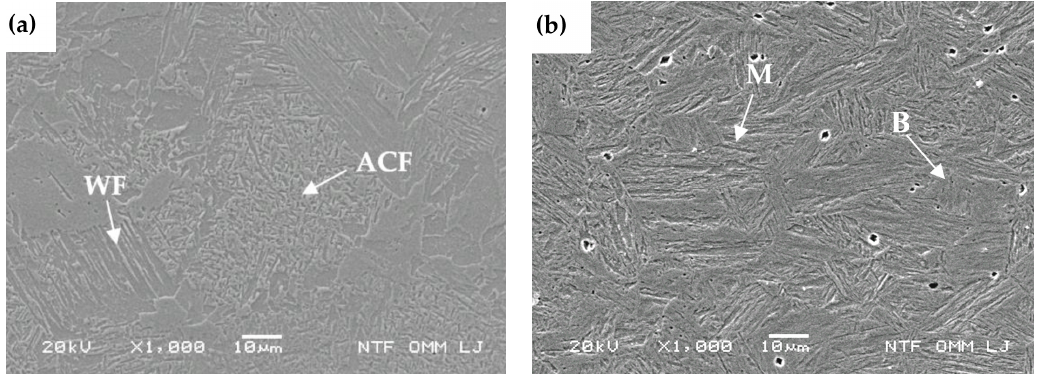
Figure 13. SEM microstructural observations: ( a ) 0.2 m/min, ( b ) 0.6 m/min; SEM.